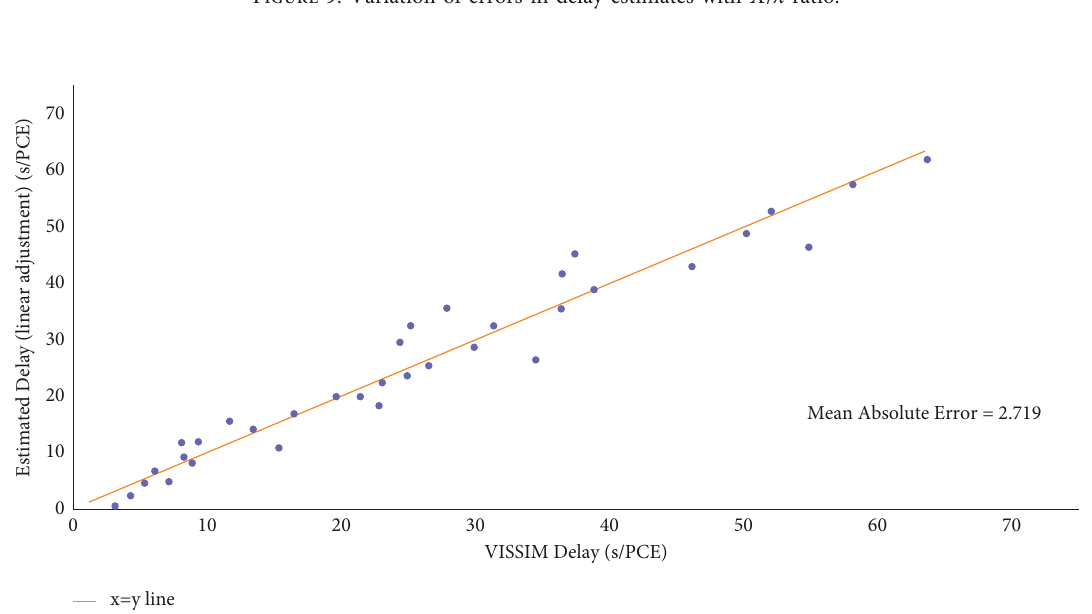
Figure 10: Comparison of actual and estimated delay with additive adjustment